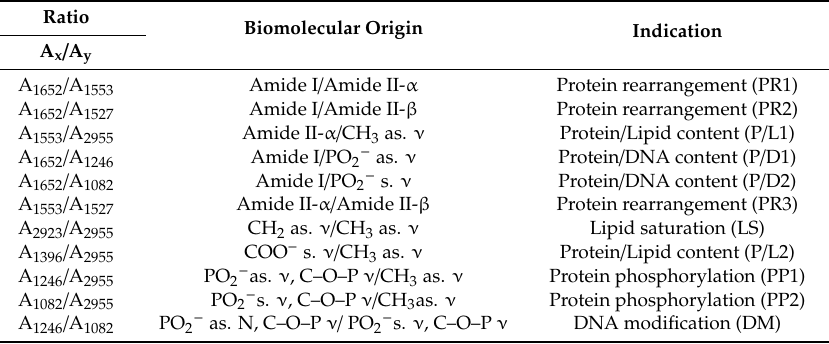
Table 1. A x / A y indicate the ratio between the absorbance of selected band [20,39,43–46]; abbreviation: as = asymmetric, s = symmetric, ν = stretching, vbr =